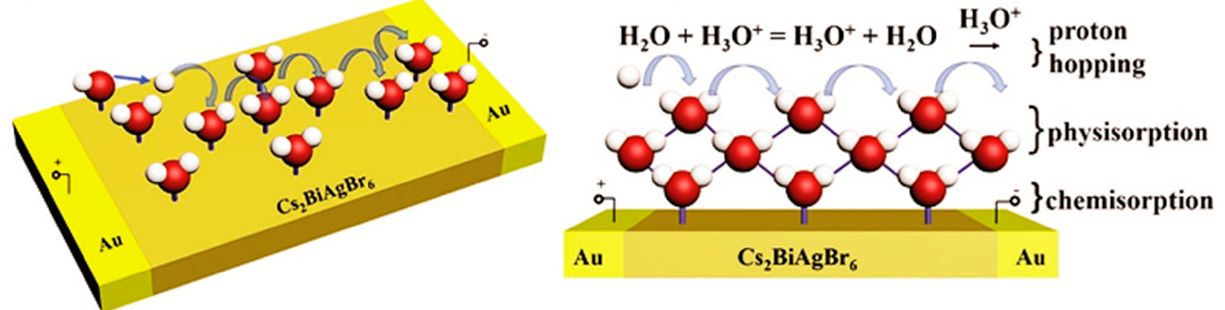
Figure 4. A diagram of the humidity sensing mechanism of Cs 2 BiAgBr 6 lead-free perovskite thin film. Reprinted/adapted with permission from Ref. [38]. Copyright © 2022 WILEY-VCH Verlag GmbH & Co. KGaA, Weinheim.